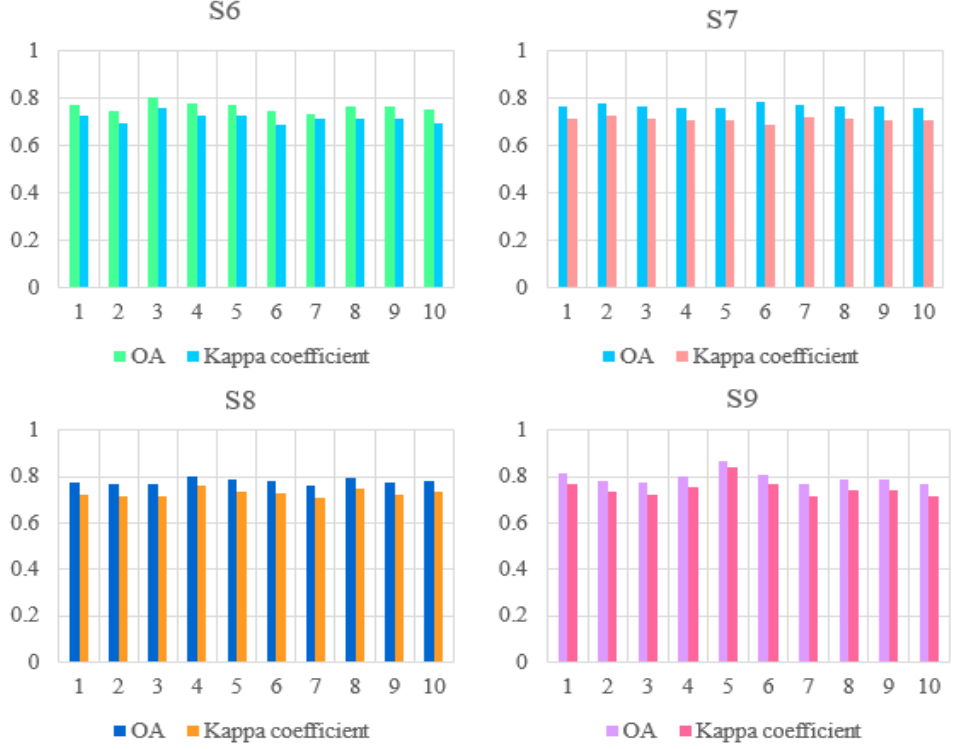
Figure 11. Map of OA and Kappa values for the performance of the models assembled from schemes 6 to 9 in ten experiments.